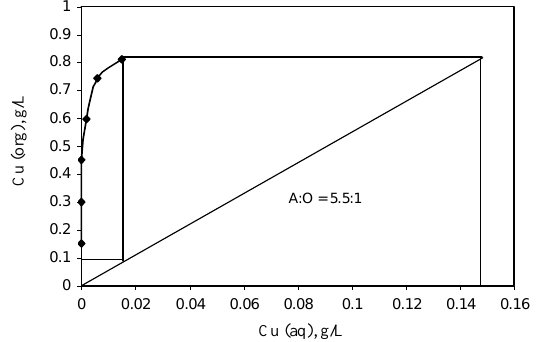
Figure 2. Extraction isotherm of copper. Aqueous phase: Cu(II): 0.150 g/L; Ni(II): 0.140 g/L; Zn(II): 0.163 g/L. Organic phase: 0.05 M LIX 984N. Equilibrium pH: 3.5 at room